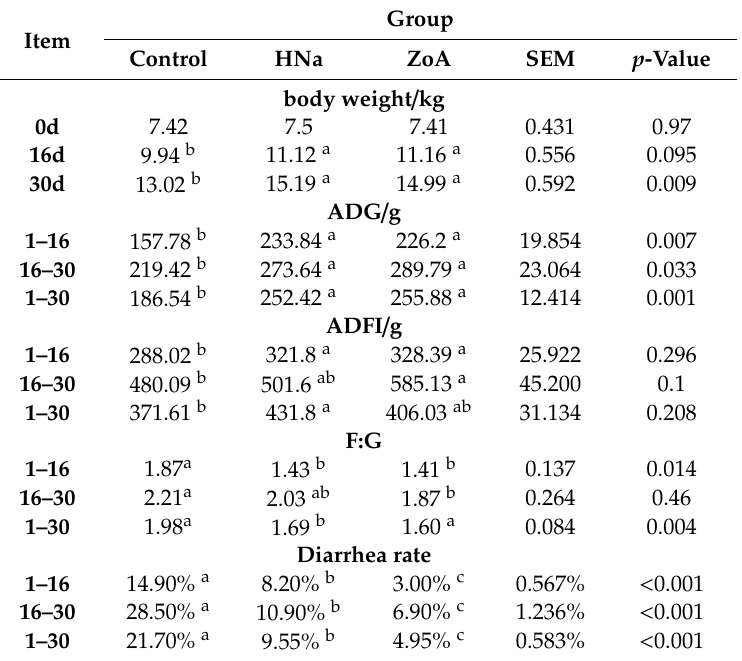
Table 2. E ff ects of HNa on growth performance of